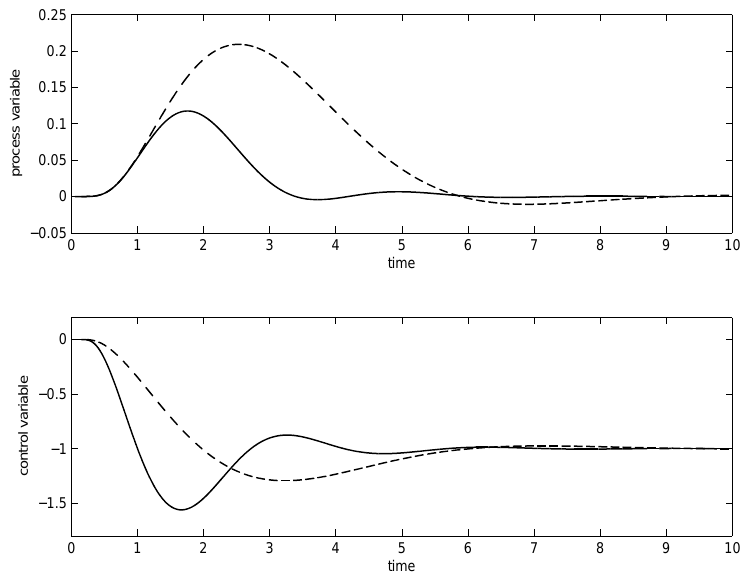
Figure 11. Load disturbance step response for PID control for a distributed lag process. Dashed line: initial tuning; solid line: after